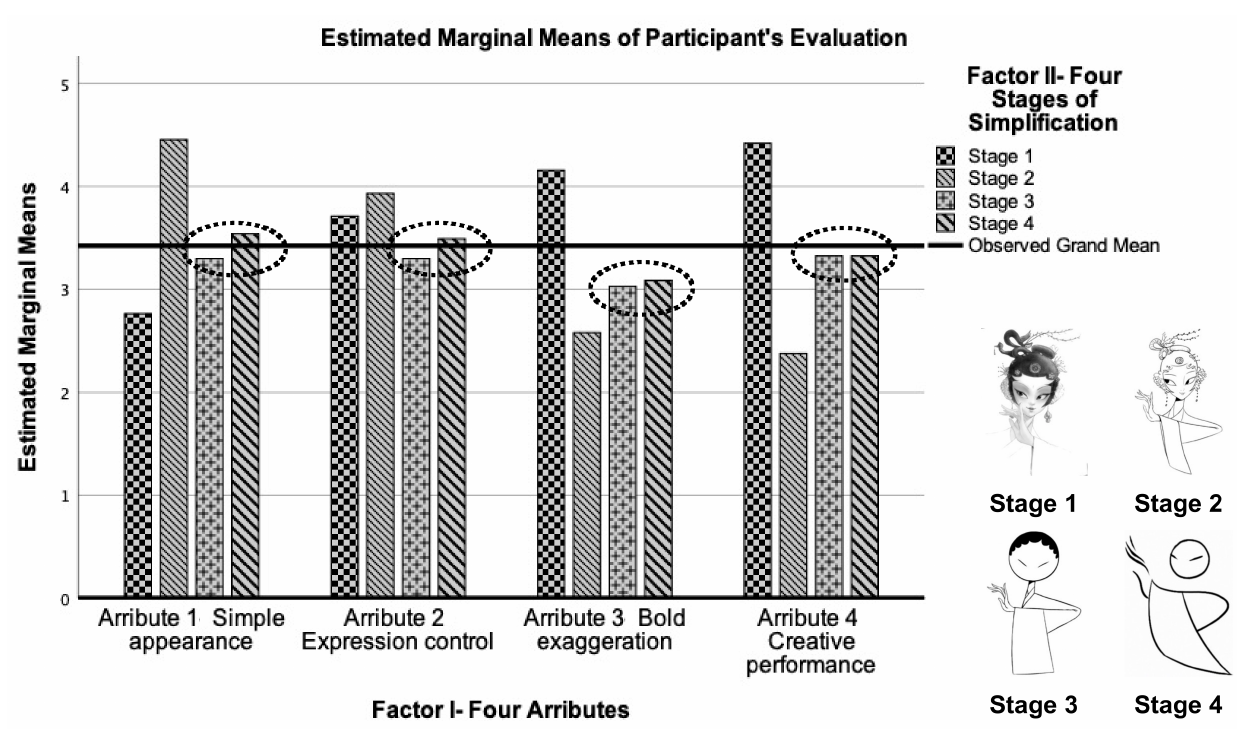
Figure 7. Profile plots of interaction between factor I (attribute) and factor II (simplified).